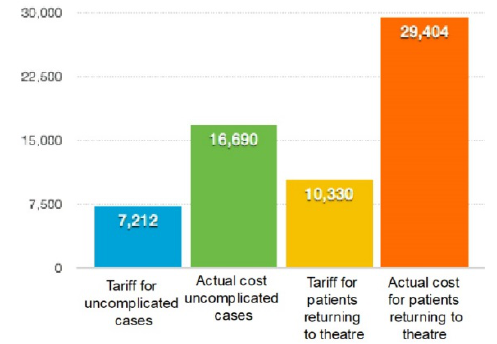
Figure 1 . Graph to show variation of mean costs in pounds paid to the trust and the actual cost of the treatment in uncomplicated cases (columns A and B) and those requiring further surgery (columns C and